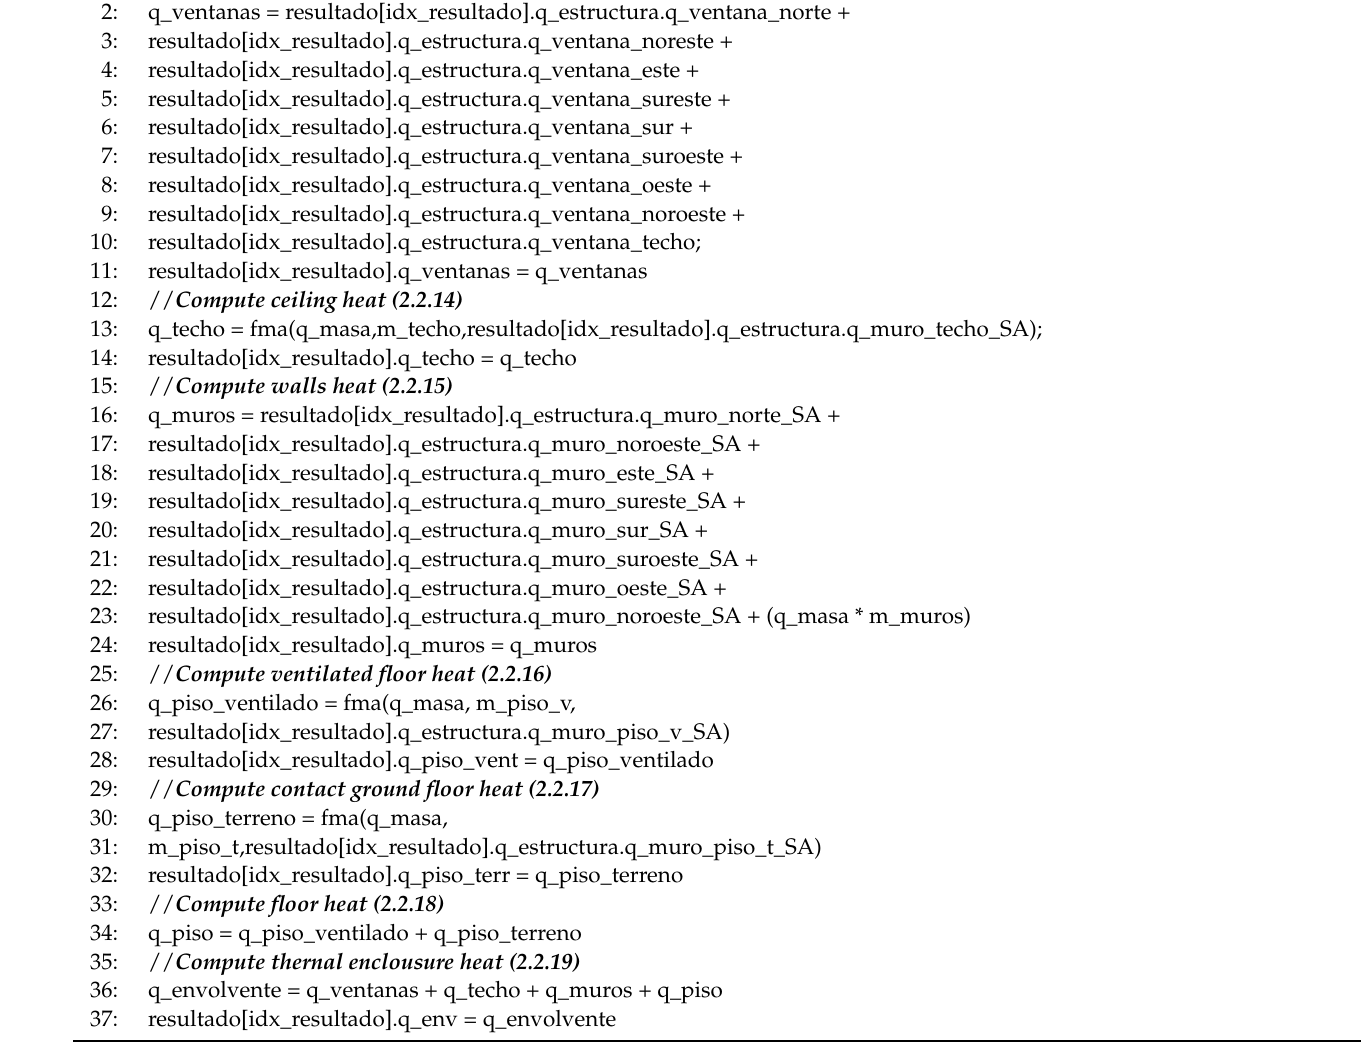
Algorithm 9. Compute windows heat(2.2.13), Compute ceiling heat (2.2.14), Compute walls heat (2.2.15), Compute ventilated floor heat (2.2.16), Compute contact ground heat (2.2.17), Compute floor heat (2.2.18) and Compute thermal enclousure heat